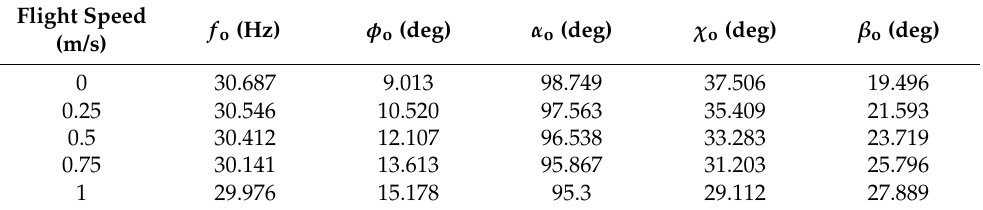
Table 2. Trimmed flight conditions from trim search algorithm for controller design.